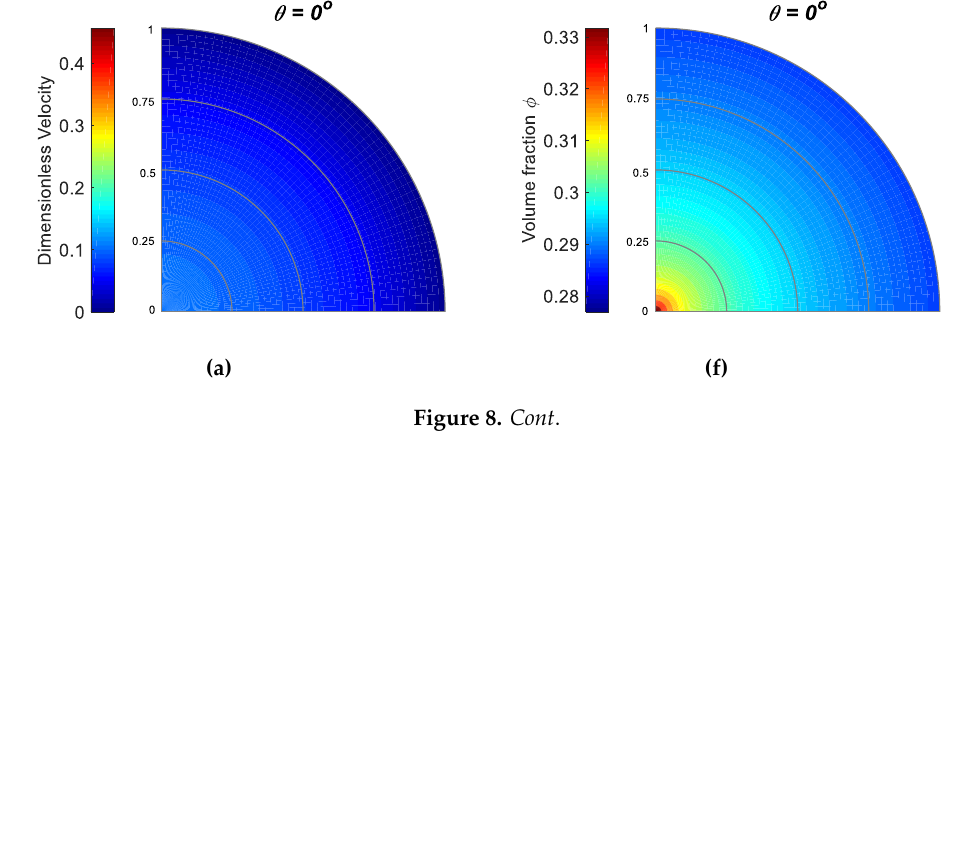
Figure 7. E ff ect of θ on ( a ) the velocity; and ( b ) the volume fraction profiles, with β = 1.82, φ avg = 0.3, R 0 = 0.1, R 1 = -2.5, R 2 = 10, R 3 = 0.01, R 4 = 0.07, R 5 = 1.8, m = 1.